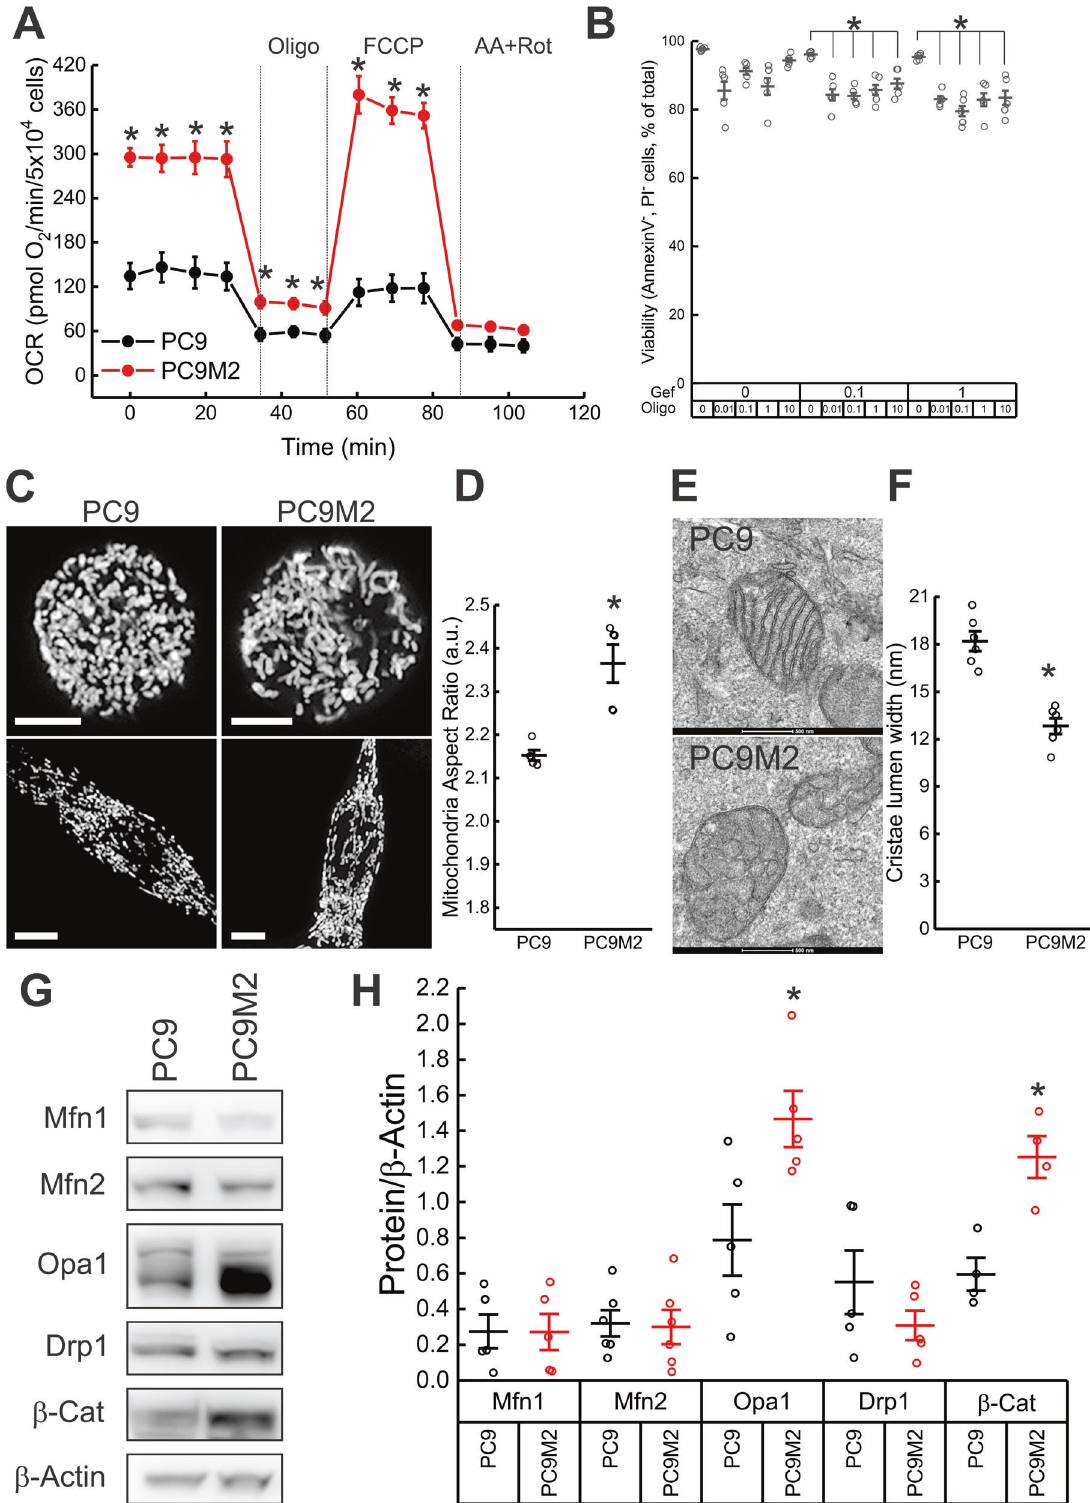
The pro-fusion mitochondria-shaping proteins also participate in establishing other features of cancer cells. For example, Opa1 is required for cancer angiogenesis [18], is upregulated in Cisplatin